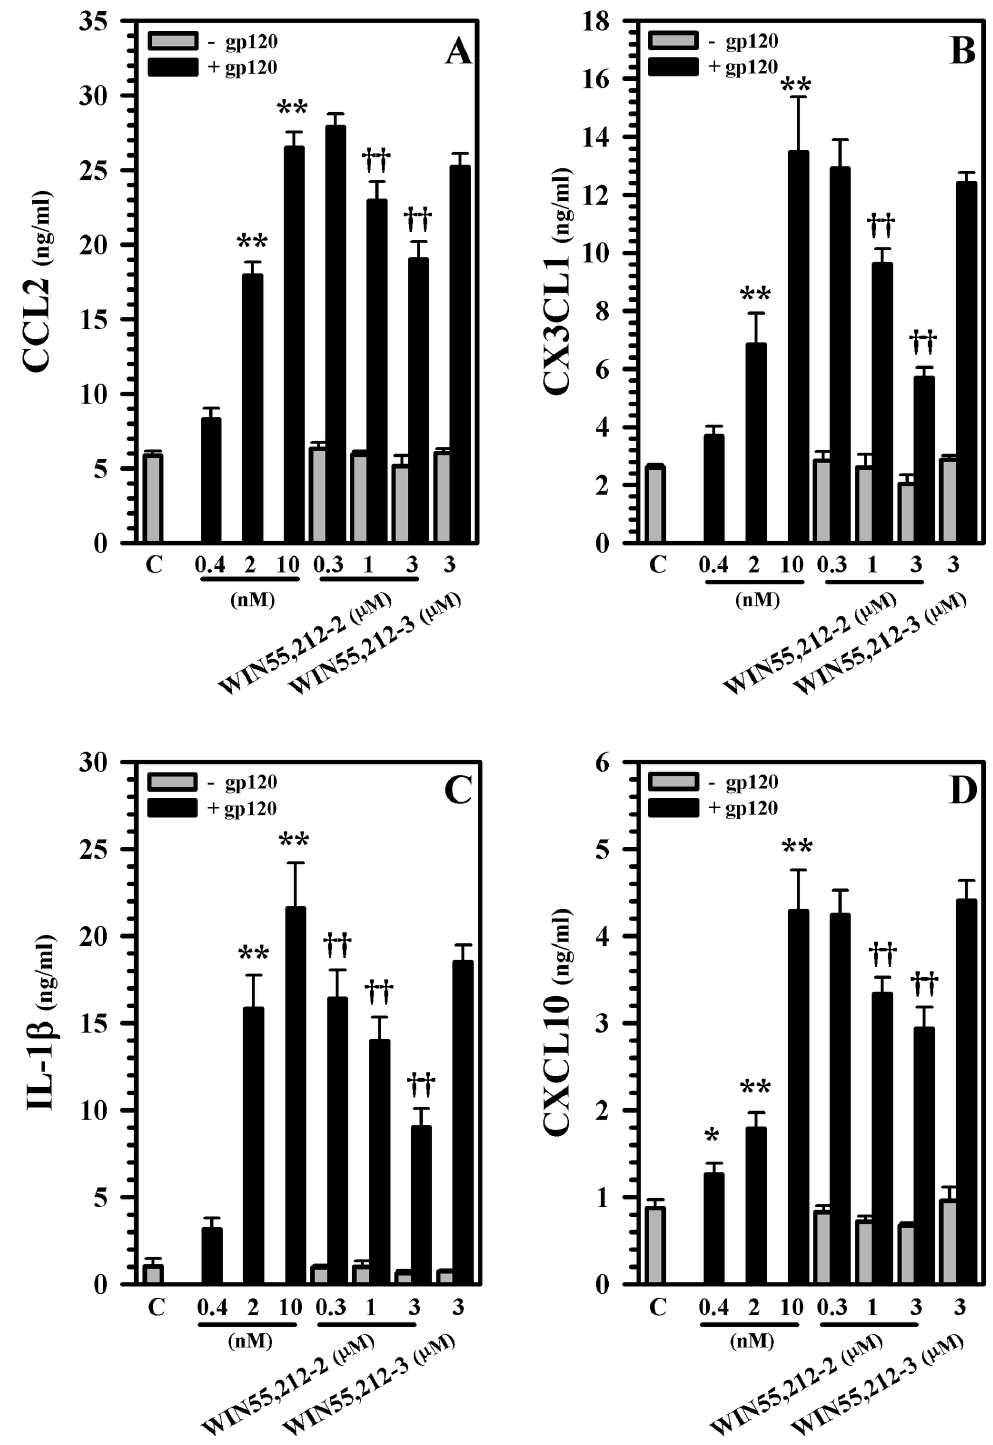
Figure 11. Blockade of gp120-induced production of CCL2, CX3CL1, IL-1β and CXCL10 in human mesencephalic neuronal/ glial cultures. Human mesencephalic neuronal/glial cultures were pretreated with WIN55,212-2 (0.3 to 3 μM) or WIN55,212-3 (3 μM) for 3h prior to gp120 (10 nM) treatment for 72h followed by supernatant collection for measurement of A ) CCL2, B ) CX3CL1, C ) IL-1β and D ) CXCL10 production by ELISA. Data are mean ± SEM of triplicates of 2 separate experiments using different brain tissue specimens. *p<0.05, **p<0.01vs. control (C); †† p<0.01 vs. gp120. doi: 10.1371/journal.pone.0077577.g011 PLOS ONE |